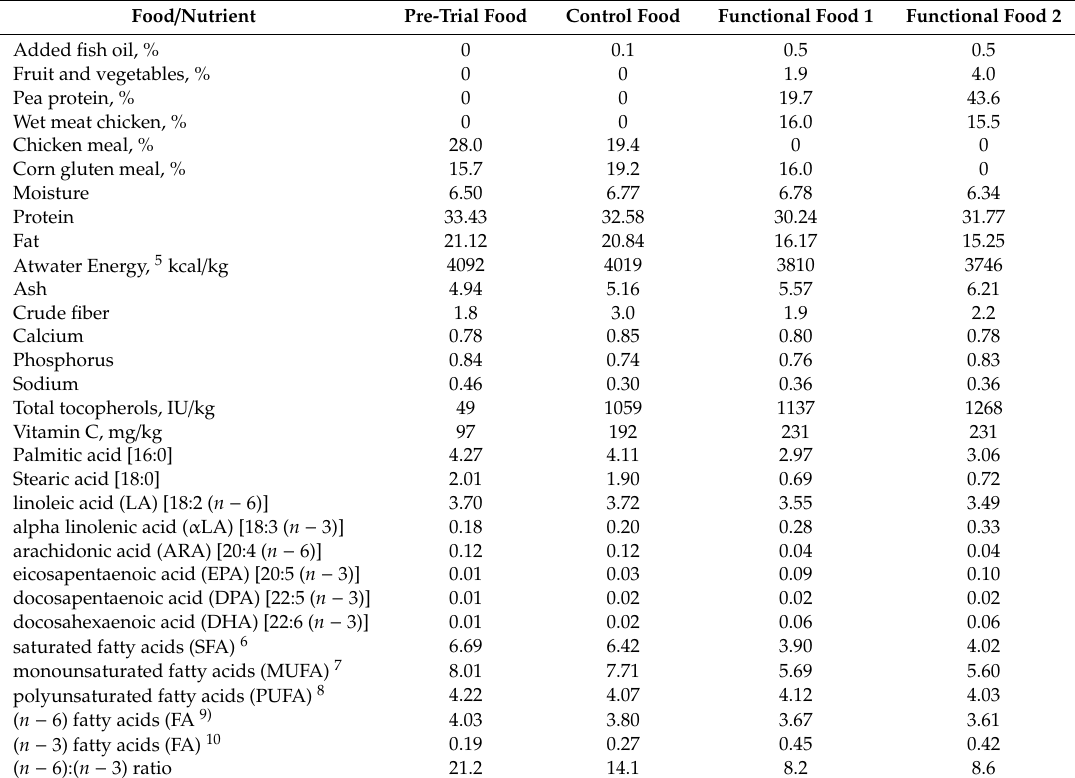
Table 2. Food composition 1 of pre-trial 2 , control 3 , and functional foods 4 . Food /